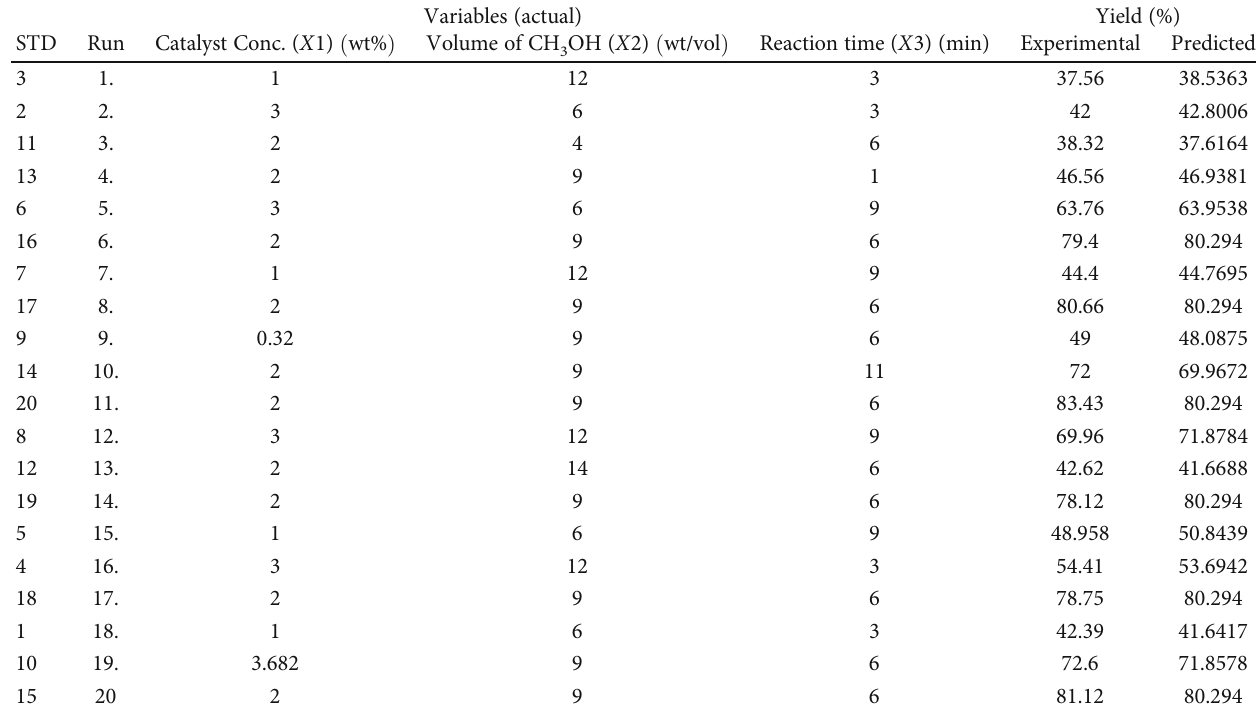
Table 5: Experimental matrix and results from RSM central composite design.